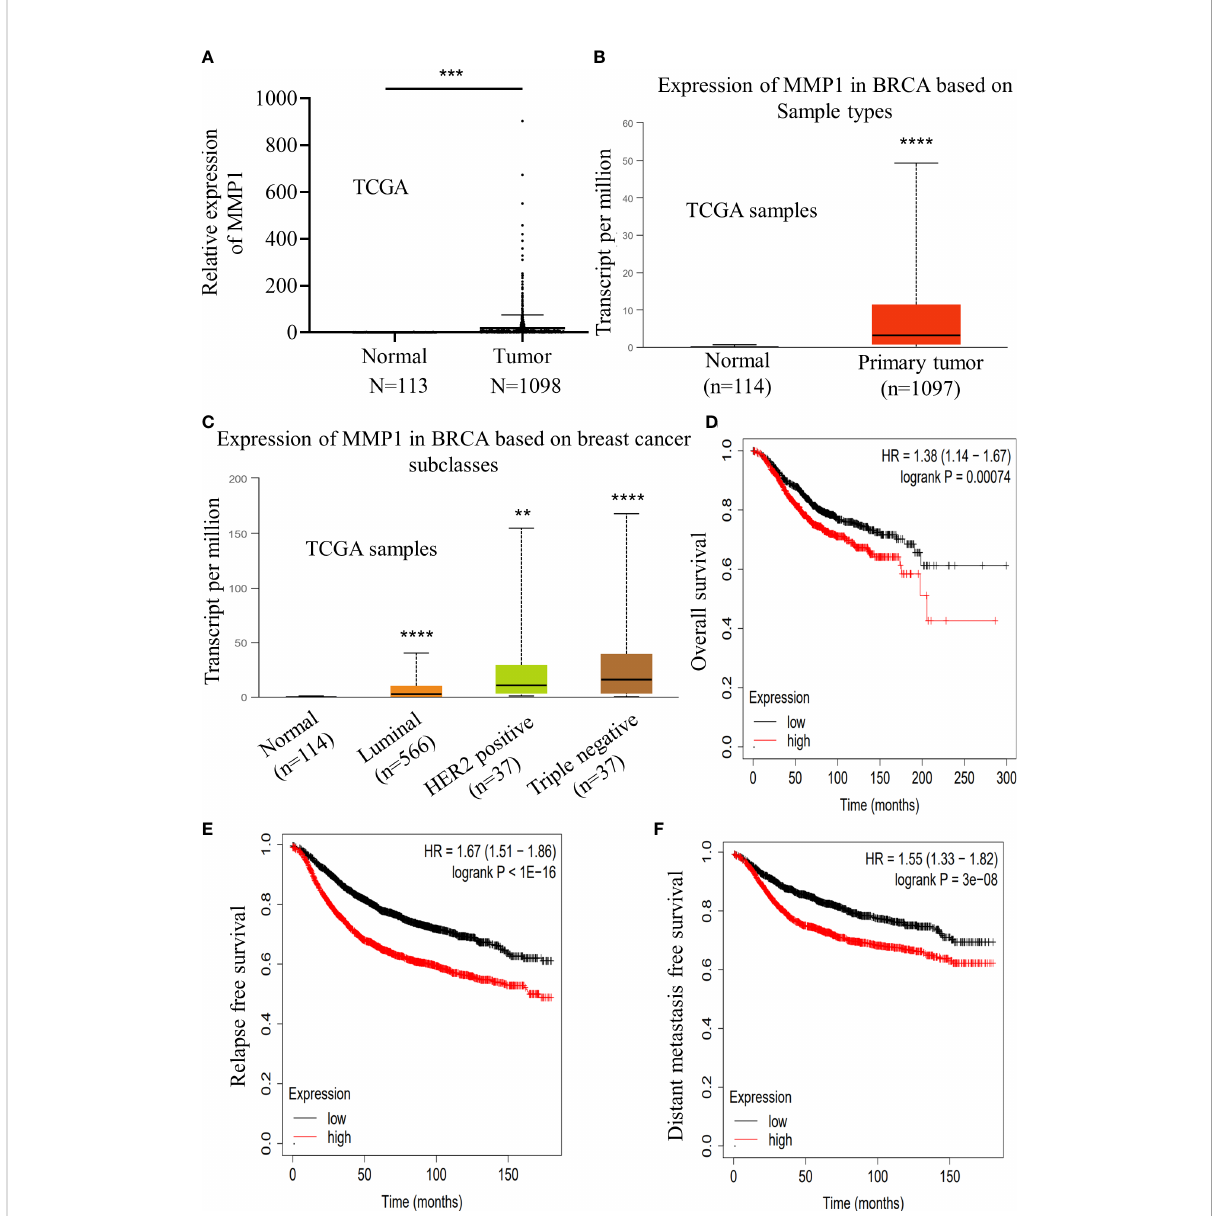
FIGURE 7 Increased expression of MMP1 indicated a poor prognosis in breast cancer. (A) Relative expression level of MMP1 in normal breast tissue samples (n=113) and breast cancer samples (n=1098) according to the TCGA database. (B) Relative expression level of MMP1 in normal breast tissue samples (n=114) and breast cancer samples (n=1097) according to the ualcan database. (C) Expression level of MMP1 in various types of breast cancer samples according to the ualcan database. (D-F) The relation of MMP1 expression levels according to the kmplot database and overall survival (D) , relapse free survival (E) and distant metastasis free survival (F) in breast cancer patients. **P<0.01; ***P<0.001;